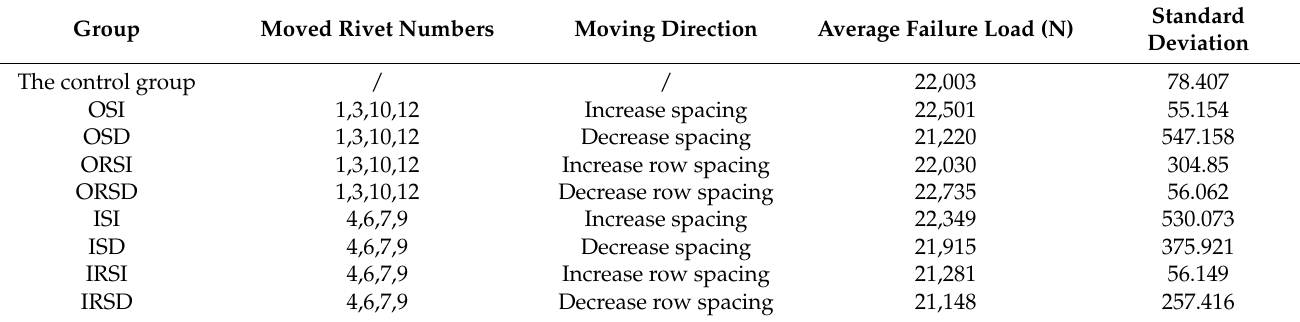
Table 2. Average value and standard deviation of static tensile strength of different experimental groups.